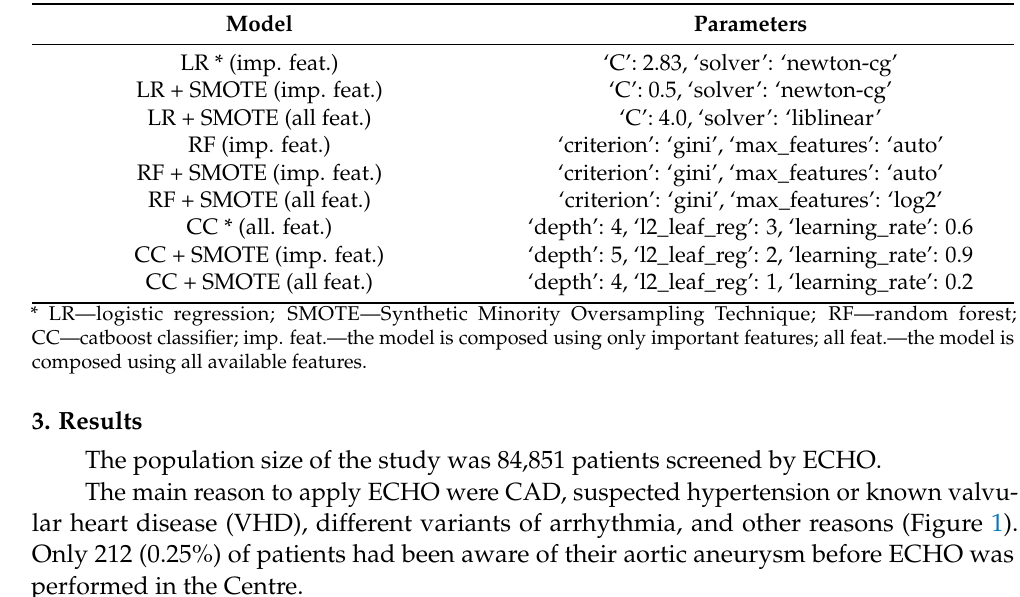
Table 3. Models and